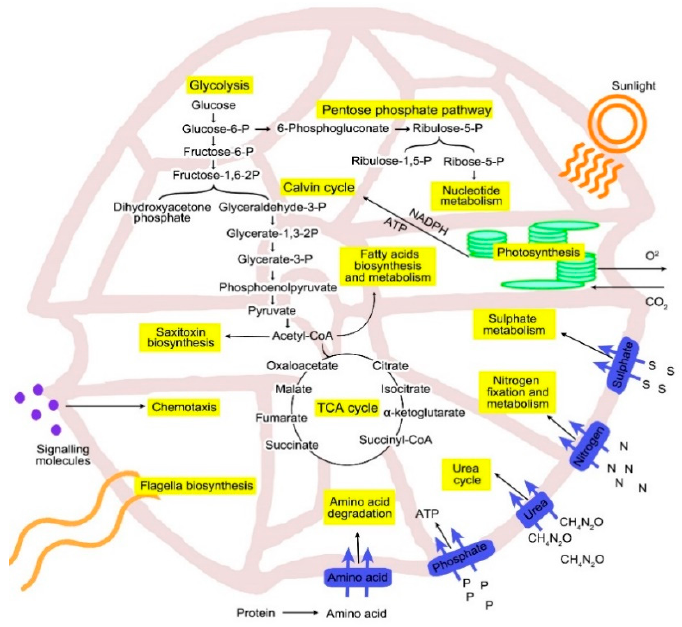
Figure 4. A metabolic pathway model of carbohydrate metabolism and related processes for A. minutum.